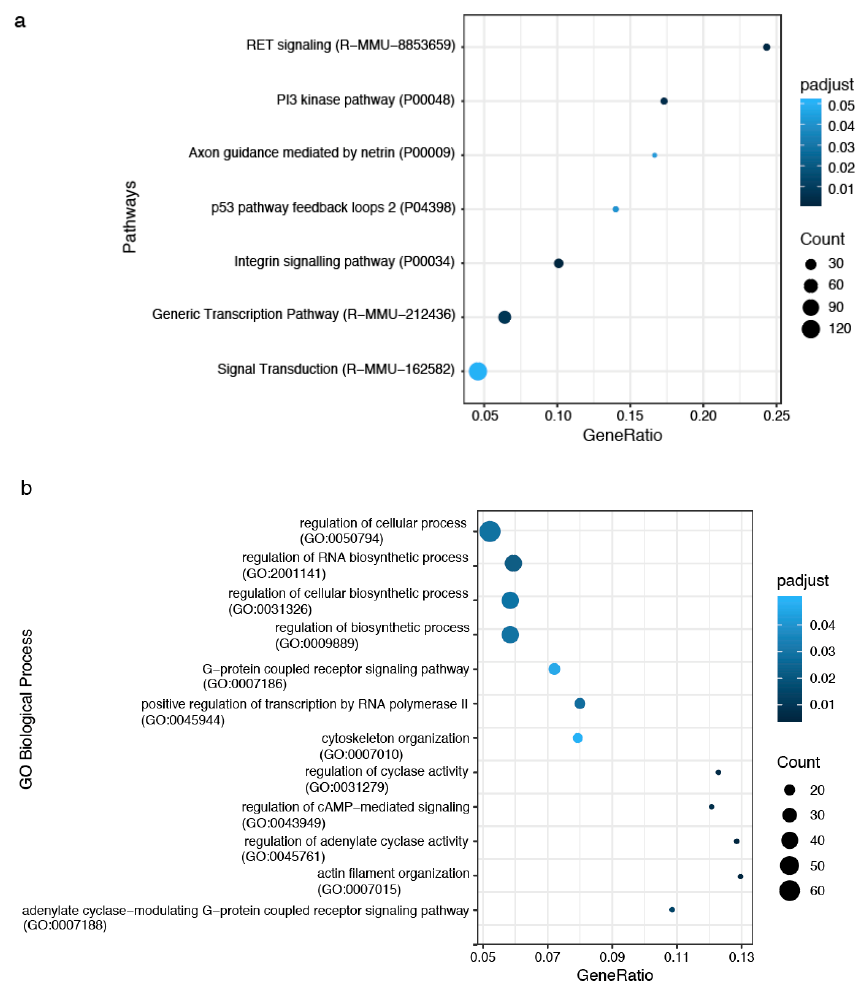
Figure 7. Dotplot of enrichment analysis in SD-STR compared to SD-SVZ. ( a ) Panther (P) and Reactome (R-MMU) pathways; ( b ) Gene Ontology Biological Process. p -adjusted < 0.05 was considered statistically significant.